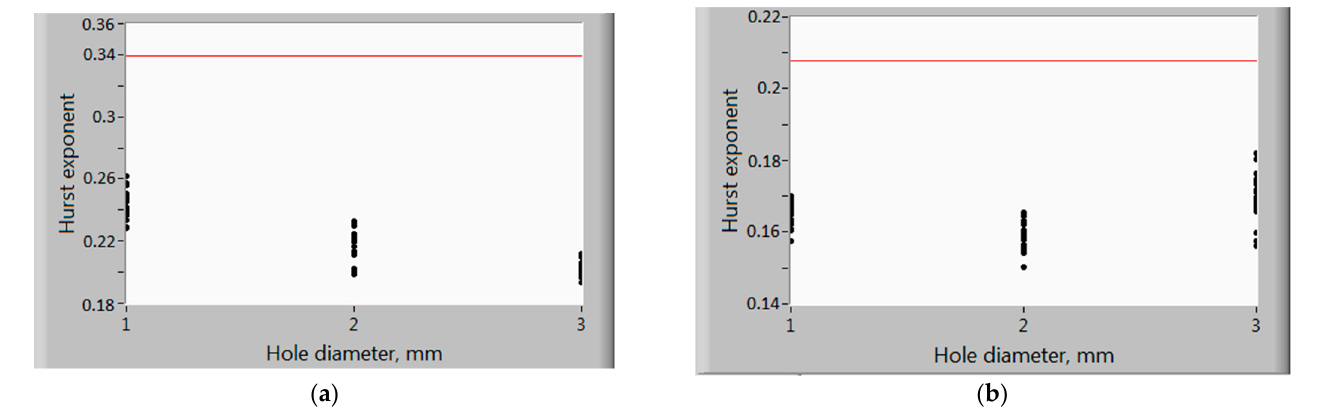
Figure 8. Values of the Hurst exponent at a pump discharge pressure of 2.5 bar: ( a ) for X-axis signals, ( b ) for Y-axis signals.